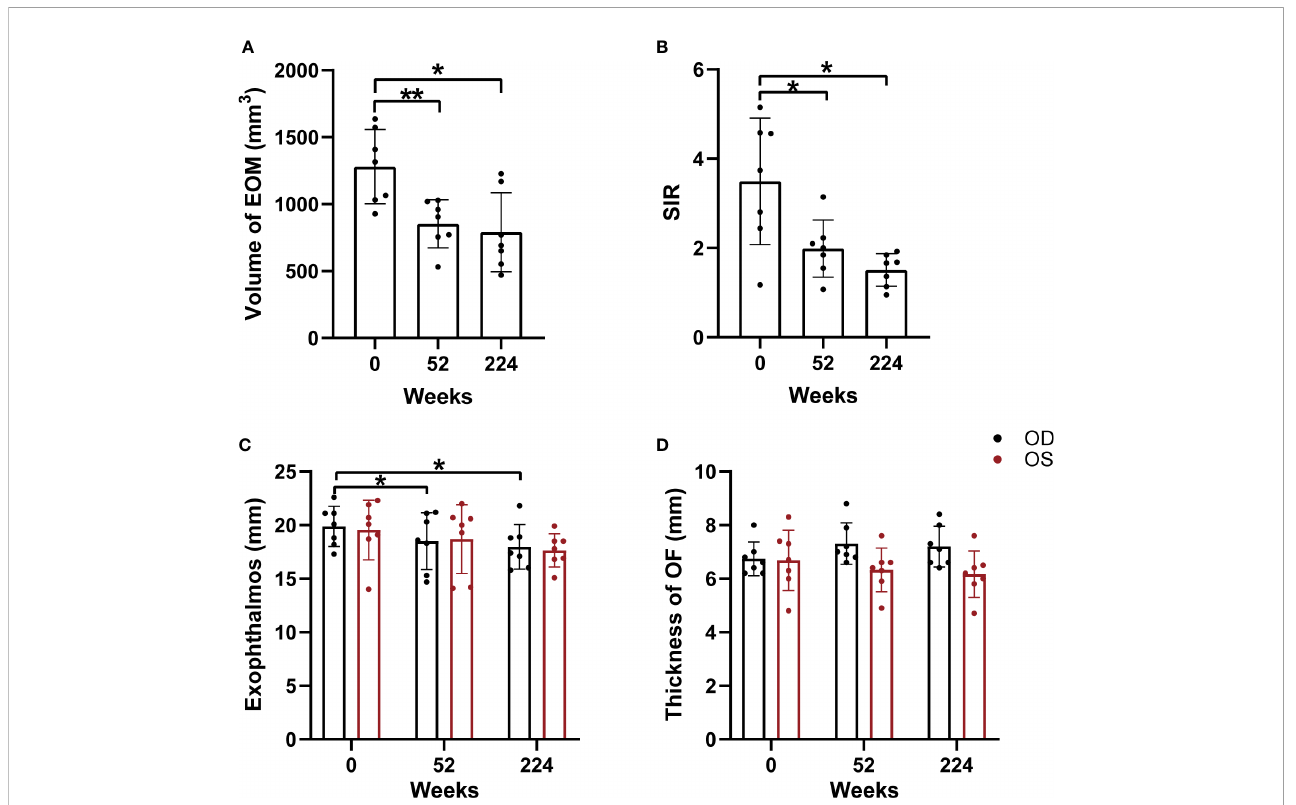
FIGURE 2 Comparisons of orbital MRI-based parameters during follow-up, including the volume of extraocular muscles with maximum signal intensity (A) , the highest SIR of extraocular muscle to ipsilateral temporal muscle (B) , the exophthalmos (C) and the thickness of orbital fat (D) . EOM, extraocular muscle; OF, orbital fat; OD, right eye; OS, left eye; SIR, the highest signal intensity ratio of extraocular muscle to ipsilateral temporal muscle. Asterisk indicated signi fi cant differences (*P < 0.05, **P < 0.01).